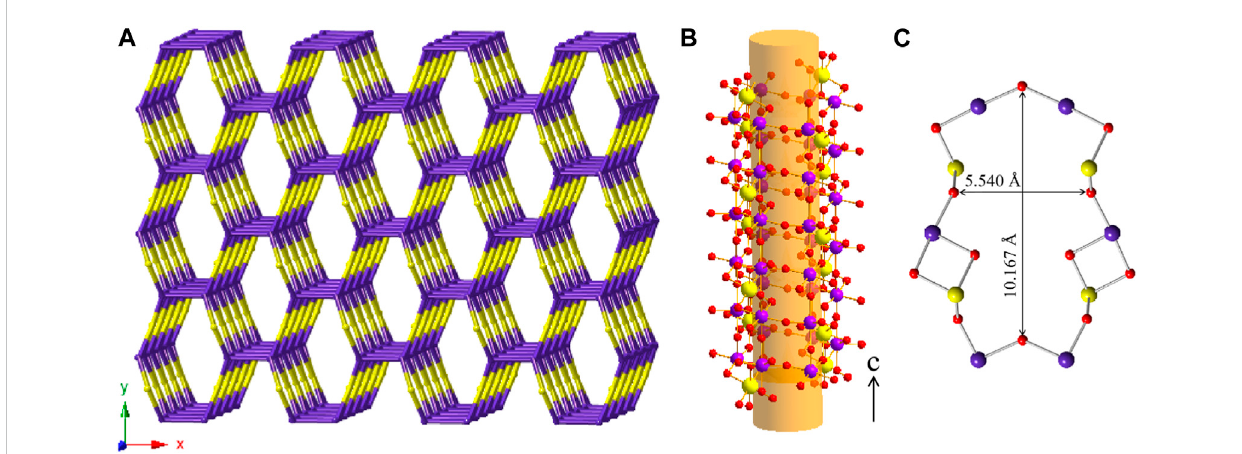
FIGURE 2 (A) View of the cation framework topology representation of K 2 [(UO 2 ) (Te 2 O 7 )] along the c -axis; (B) Side view of one 10-MRs tube along the [001] direction with ball-and-stick representation; (C) the pore size of a 10-MRs of the [(UO 2 )Te 2 O 7 ] tube. K, Te, U and O atoms are shown in green, purple, yellow and red,